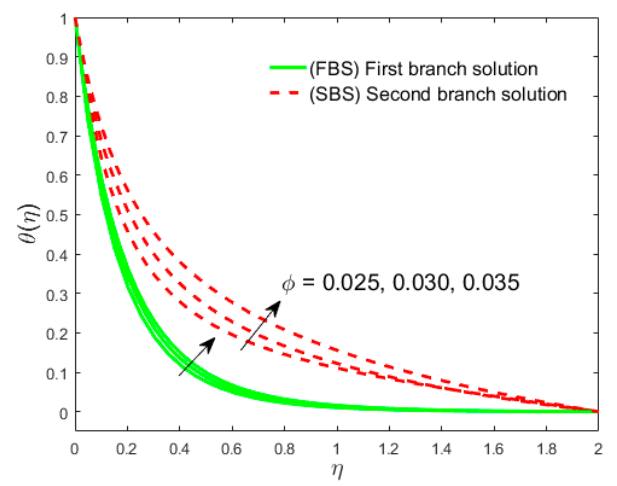
Figure 13. The impact of φ on θ ( η ) .